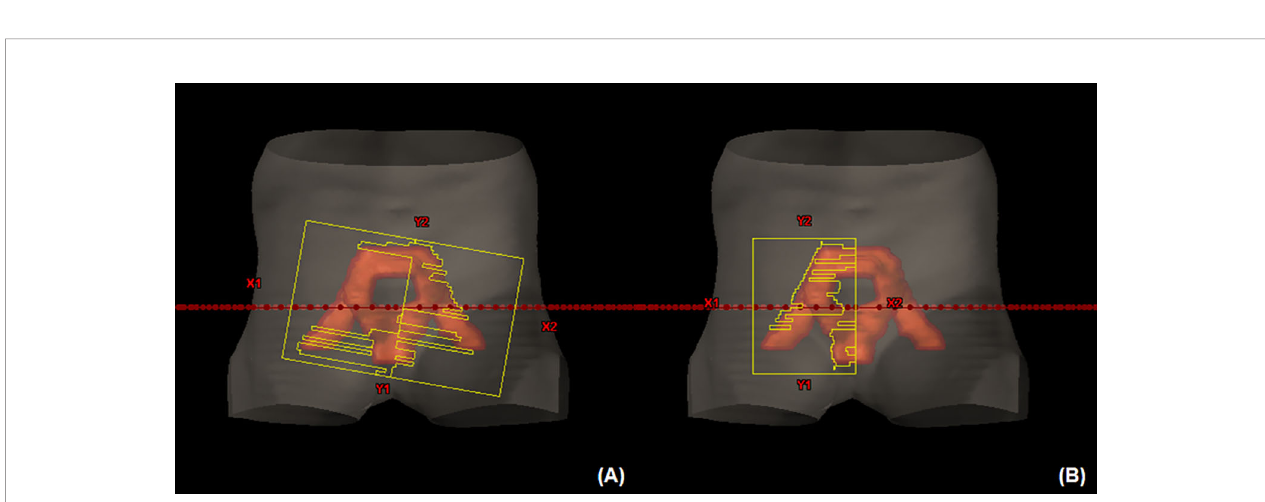
FIGURE 5 | (A) A suboptimal multi-leaf collimator (MLC) segment in volumetric modulated arc therapy (VMAT) optimized using a fully opened fi eld compared to (B) an MLC segment for the planning target volume in VMAT optimized using a half-beam technique at the beam ’ s eye